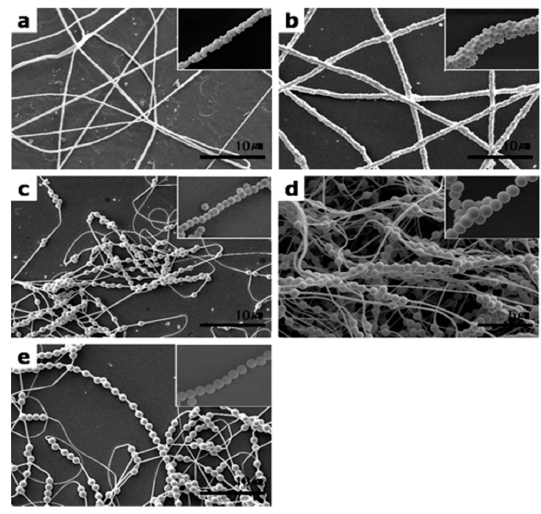
Figure 6. Scanning electron microscope (SEM) images of the structures and morphology of polyacrylamide nanofibres with the increase of SiO 2 nanoparticle sizes: ( a ) 100 nm, ( b ) 300 nm, ( c ) 450 nm, ( d ) 700 nm, and ( e ) 1000 nm. Reprinted with permission from [26] American Chemical Society,